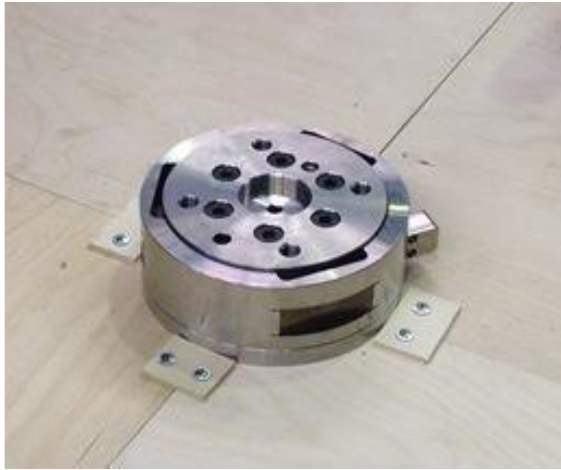
Figure 4. Schunk FTD strain gauge.